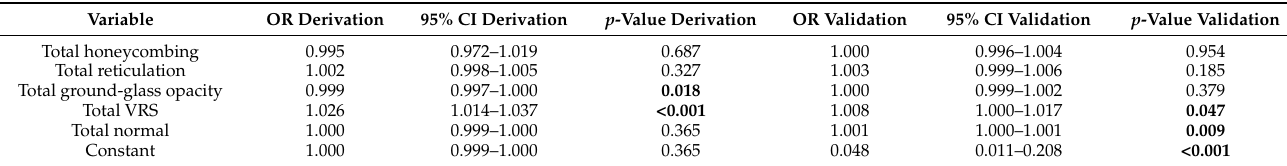
Table 3. Multivariable logistic regression analysis of CALIPER variables relative to diagnosis across two tertiary medical centers (labeled derivation and validation) for a diagnosis of